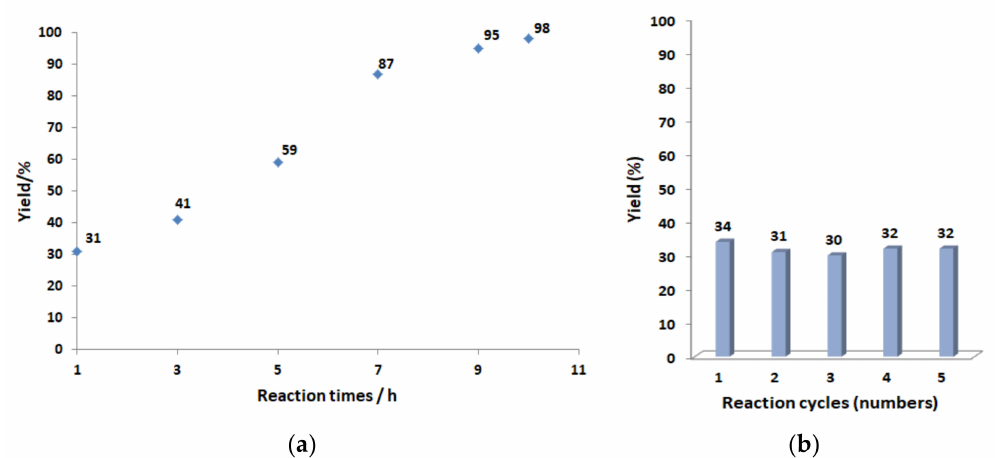
Figure 3. ( a ) Plot of GC yield versus reaction time. Reaction conditions: propylene oxide (2.9 g, 50 mmol), an initial pressure of 3 MPa CO 2 , substrate/catalyst = 5000, Iq-POC (12.1 mg, 0.01 mmol), ZnBr 2 (22.5 mg, 0.1 mmol), 120 ◦ C. The selectivities of all the results were >99%. All the results were averaged over two runs, and ( b ) the recyclability test of catalyst Iq-POC . Reaction conditions: propylene oxide (5.8 g, 100 mmol), an initial pressure of 3 MPa CO 2 , substrate/catalyst = 5000, Iq-POC (24.2 mg, 0.02 mmol), ZnBr 2 (45 mg, 0.2 mmol), 1 h, 120 ◦ C.